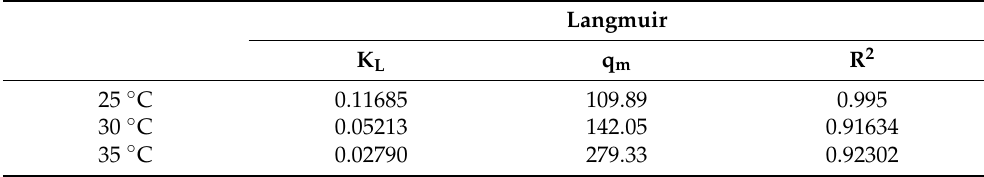
Table 2. The parameters of the Langmuir